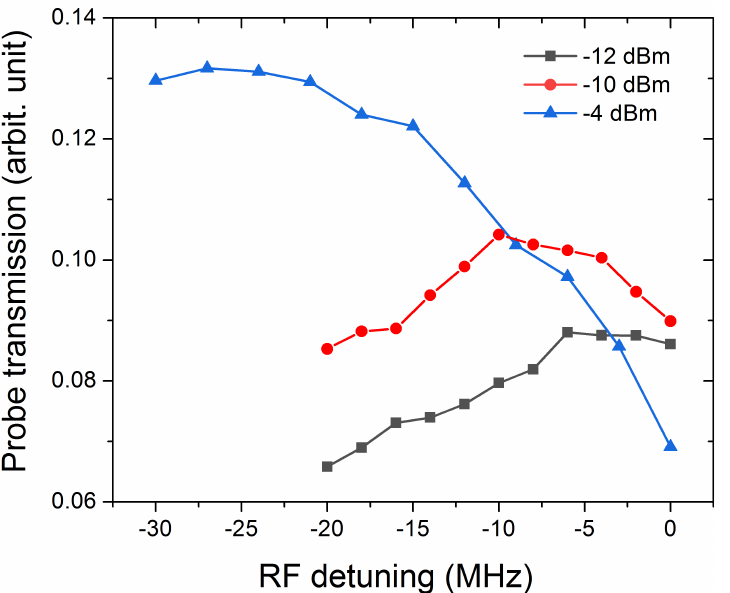
Figure 8. The maximum dynamical signal response dependent on the RF detunings at different MW RF powers in Figure 6, where obvious optimization can be